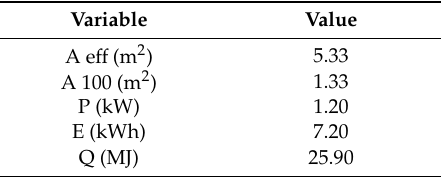
Table 6. Group results from the second example simulation.